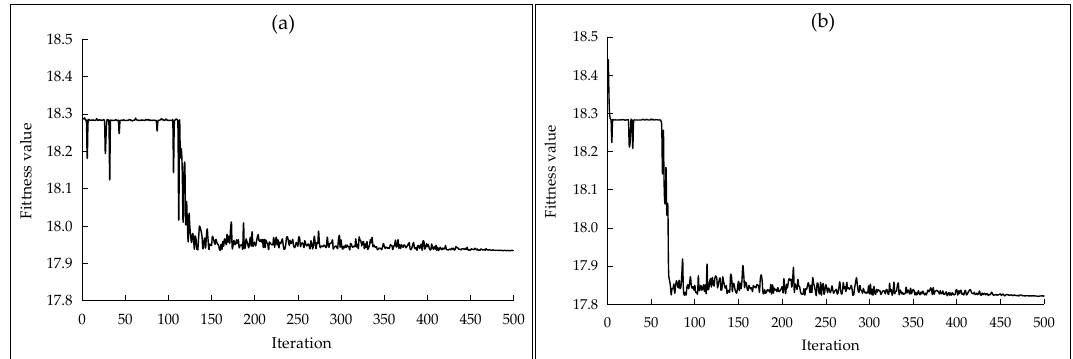
Figure 9. Fitness value convergence curve shown for differential evolution grey wolf optimization (DE–GWO) ( a ) and modified differential evolution grey wolf optimization (MDE–GWO) ( b ) algorithms.